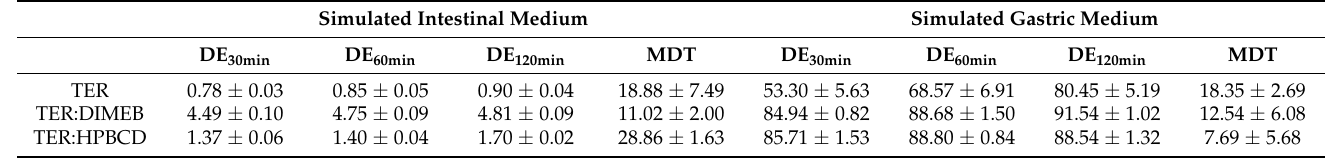
Figure 13. In vitro dissolution studies of TER and products in simulated intestinal fluid ( A ) and simulated gastric fluid ( B ).